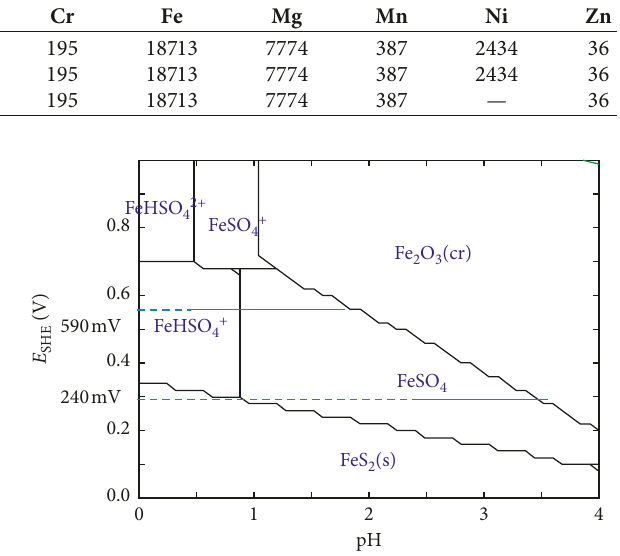
2 O constructed using